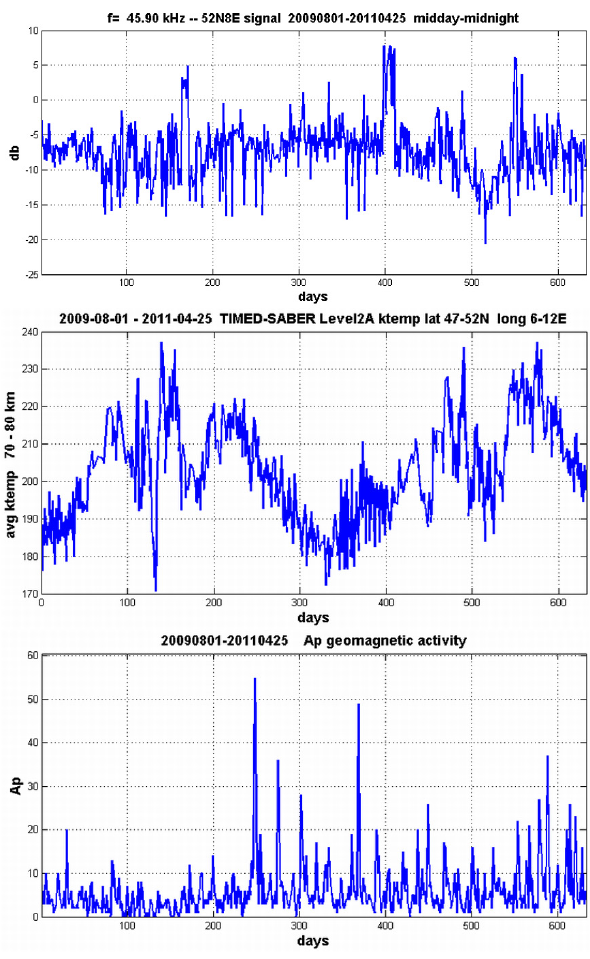
Fig. 3. Top: NSY log amplitude difference midday-midnight (2h averages); Note the larger variations on a days to weeks scale dur- ing winter time (days 60–200: October 2009–February 2010 and days 400–560: October 2010–February 2011) compared to sum- mer time – more prominently seen with the kinetic temperature but also clearly present in the VLF/LF data. Middle: SABER meso- sphere kinetic temperature: 70–80km average for the region 47– 52 ◦ N, 6–12 ◦ E (containing the Rx oriented half of the propagation path) within 1 August 2009–25 April 2011. Bottom: The Ap-index for the same time range exhibits no significant correlation to the VLF/LF or kinetic temperature data.